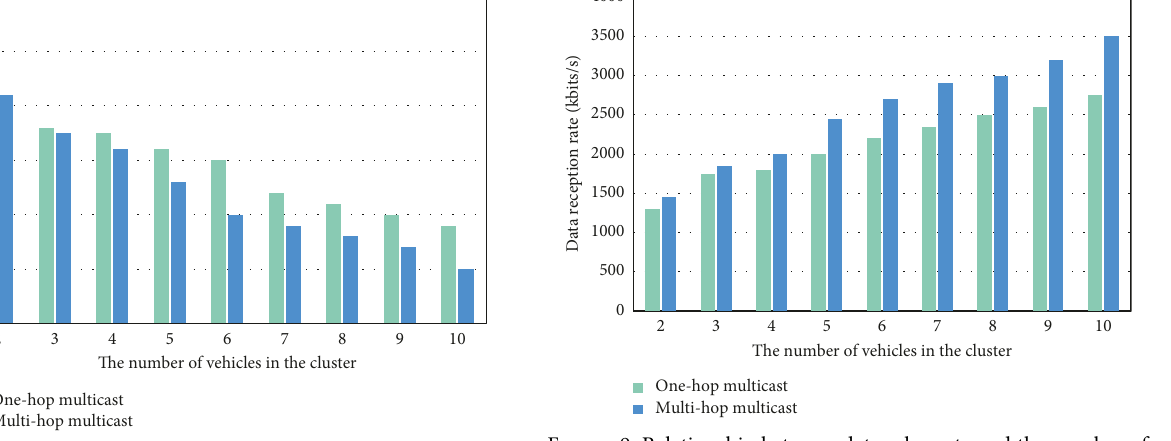
Figure 7: Relationship between data reception delay and the number of vehicles in a cluster based on multihop multicast and one-hop multicast algorithms.